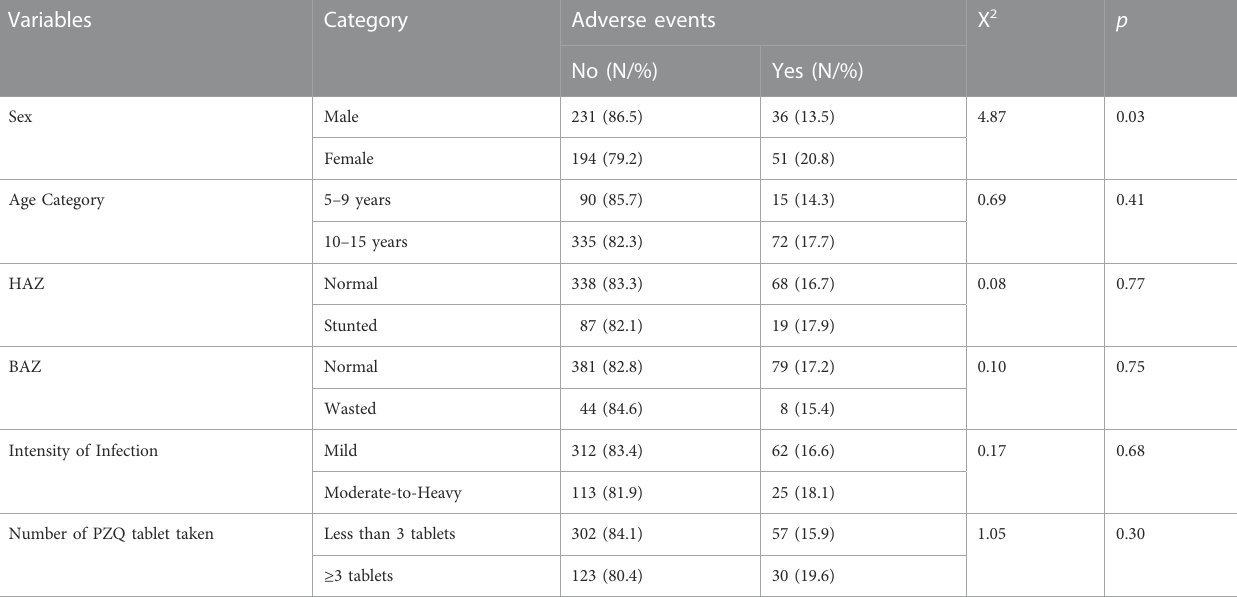
TABLE 5 Factors associated with occurrence of adverse events.